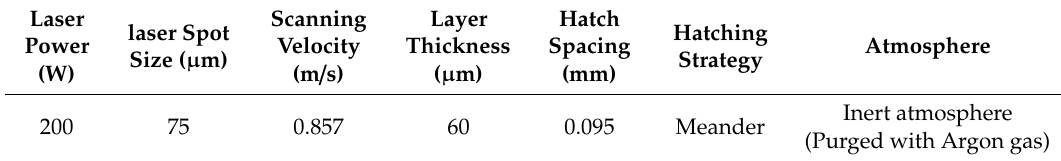
Table 2. Process parameters of selective laser melting (SLM).